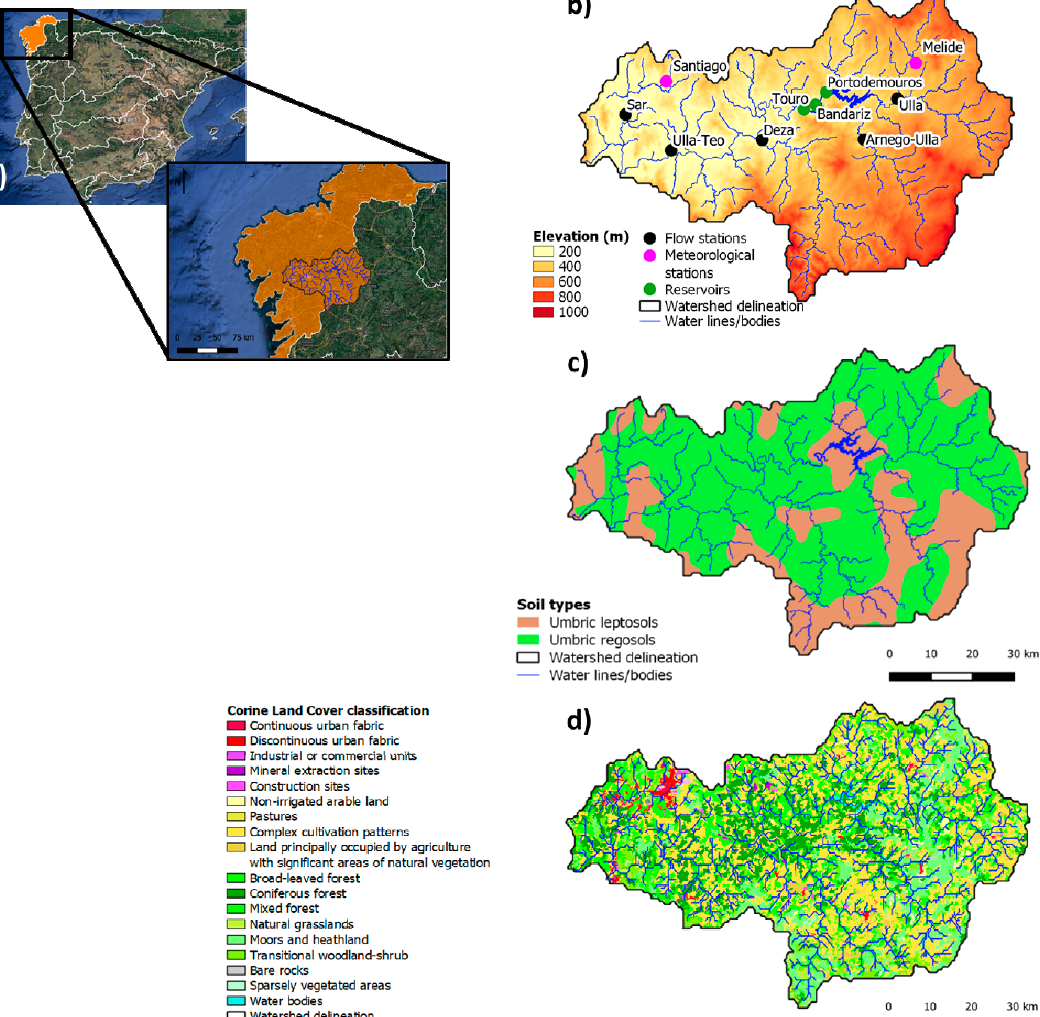
Figure 1. ( a ) Location of the study area; ( b ) Digital terrain model and location of reservoirs and hydrometric stations; ( c ) main soil units; ( d ) main land uses [29].